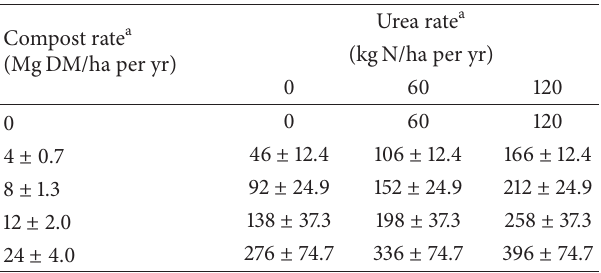
Table 3: Actual nitrogen (N) treatment rates were combinations of urea N and N in composted cattle